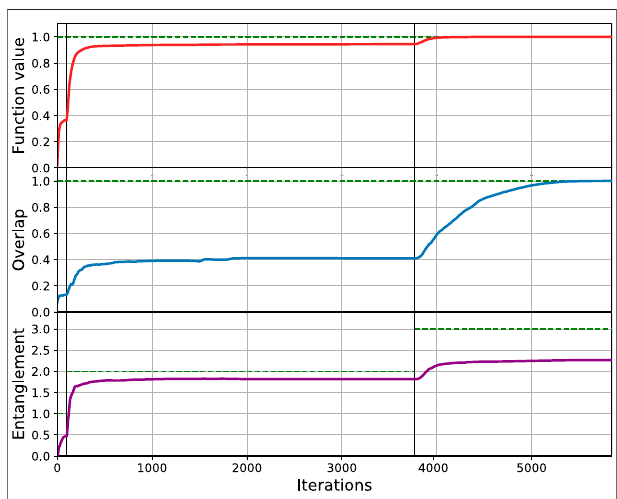
FIGURE 2 | Algorithm demonstration on randomly generated 6-qubit unitaries Q : the value of Eq. 9 (upper) , overlap between the variational state andtheclosesteigenstateof Q (middle) ,andthevonNeumannentropyofthe subsystem of the fi rst three qubits (lower) . The vertical solid lines indicate the iteration numbers after which k , the number of ebits that the MPS ansatz can support, increases by 1. The plot is obtained by averaging over 10 randomly generated unitaries Q